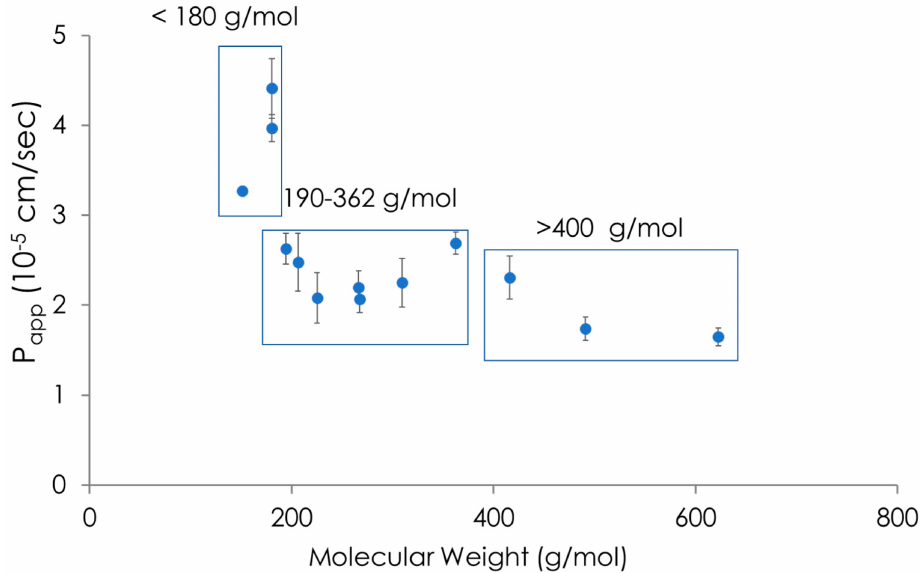
Figure 13. Correlations of P app values measured using regenerated cellulose membranes and molec- ular weights (original data form Di Cagno et al. [66]). A quite evident correlation of P app ≈ 1/mw